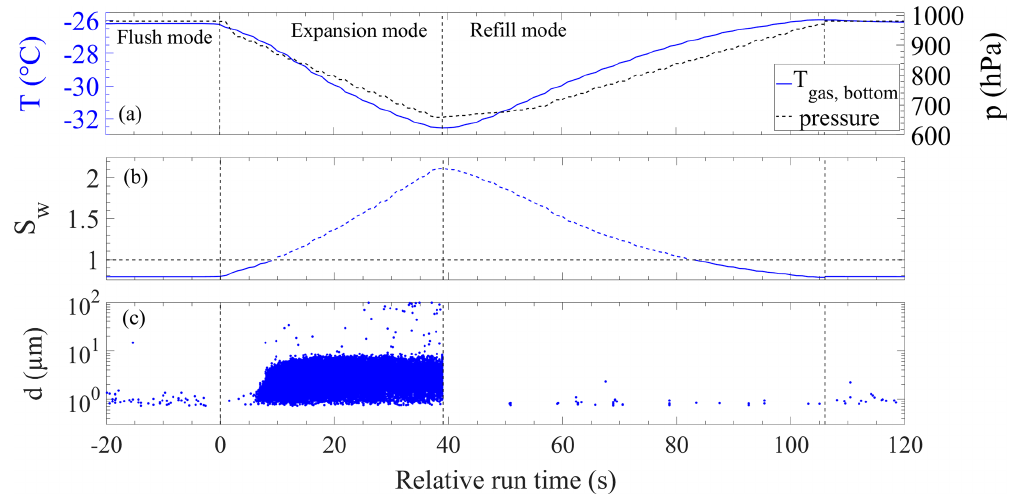
Figure 3. A typical run of PINE-1A showing both cloud droplet formation and ice formation during the cloud expansion mode. (a) Lowest gas temperature ( T ; blue line) and pressure ( p ; black line) measured in the chamber. (b) Calculated liquid water saturation ratio ( S w ). (c) Optical particle diameter ( d ) detected in the OPC. This panel shows each single particle detected by the OPC plotted as a single blue dot at the time of occurrence and with its measured optical